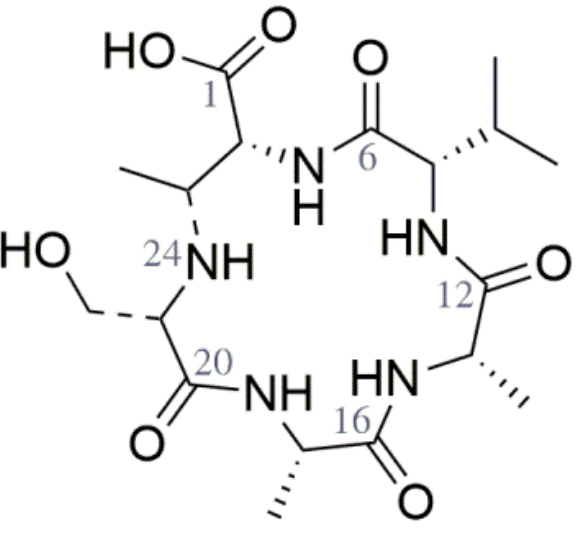
Figure 3. The structure of isolated bonsecamin.